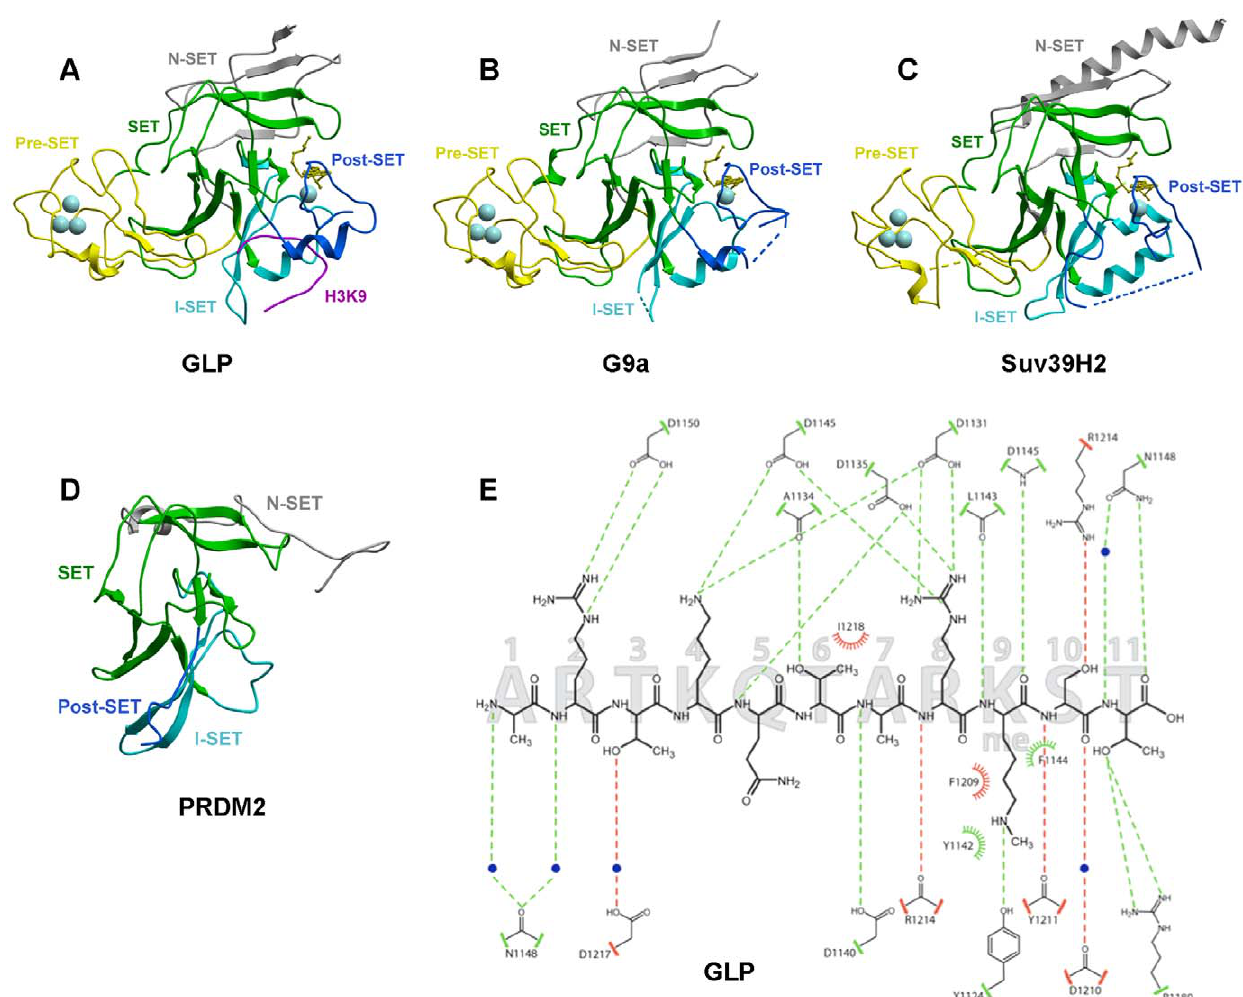
Figure 2. Structures of four human H3K9 HKMTs. (A) a ternary complex of GLP with SAH and a H3K9Me substrate peptide, (B) G9a in complex with SAH, (C) SUV39H2 in complex with SAM and (D) PRDM2, highlighting Pre-Set, SET, I-SET, Post-SET domains and the conserved presence of an N- SET domain. The co-factor is shown as yellow sticks. Residues flanking un-resolved regions are connected by dotted lines. (E) The detail of the interactions between GLP and an H3K9Me